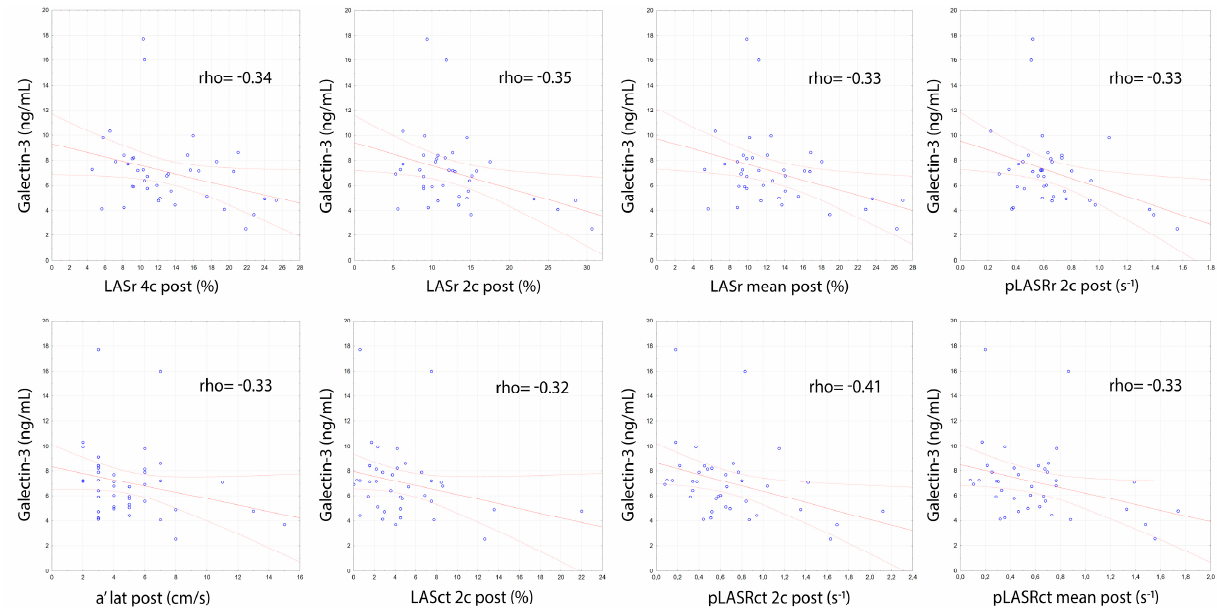
Figure 2. Correlations of galectin-3 concentration with echocardiographic measurements assessing left atrial compliance and